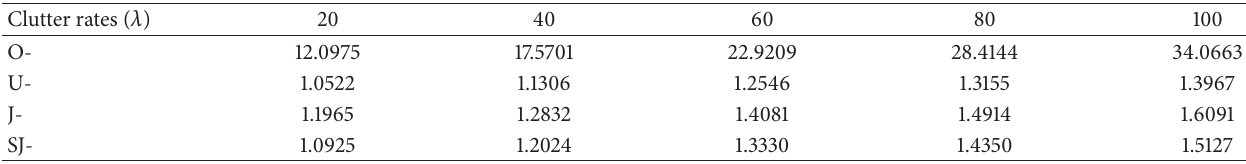
Table 5: Computational time (sec) in different clutter